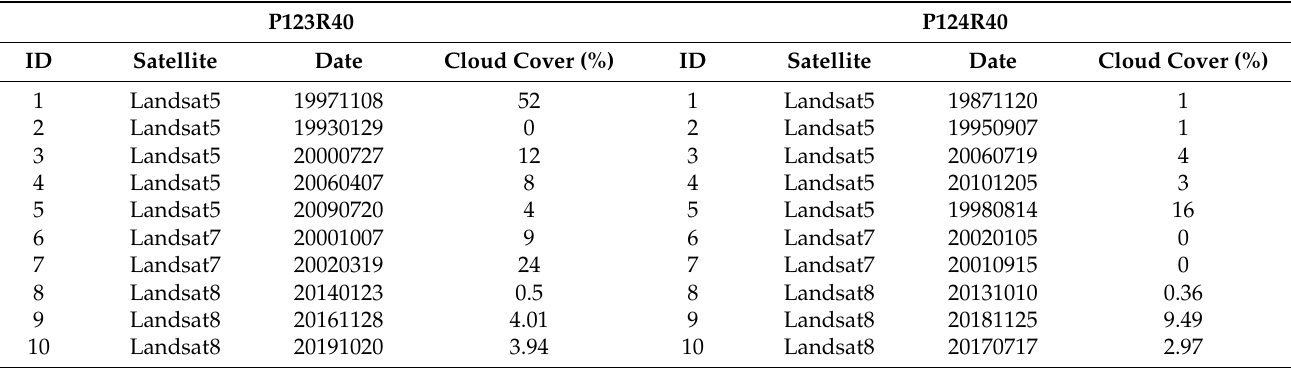
Table 3. Selected images used for accuracy